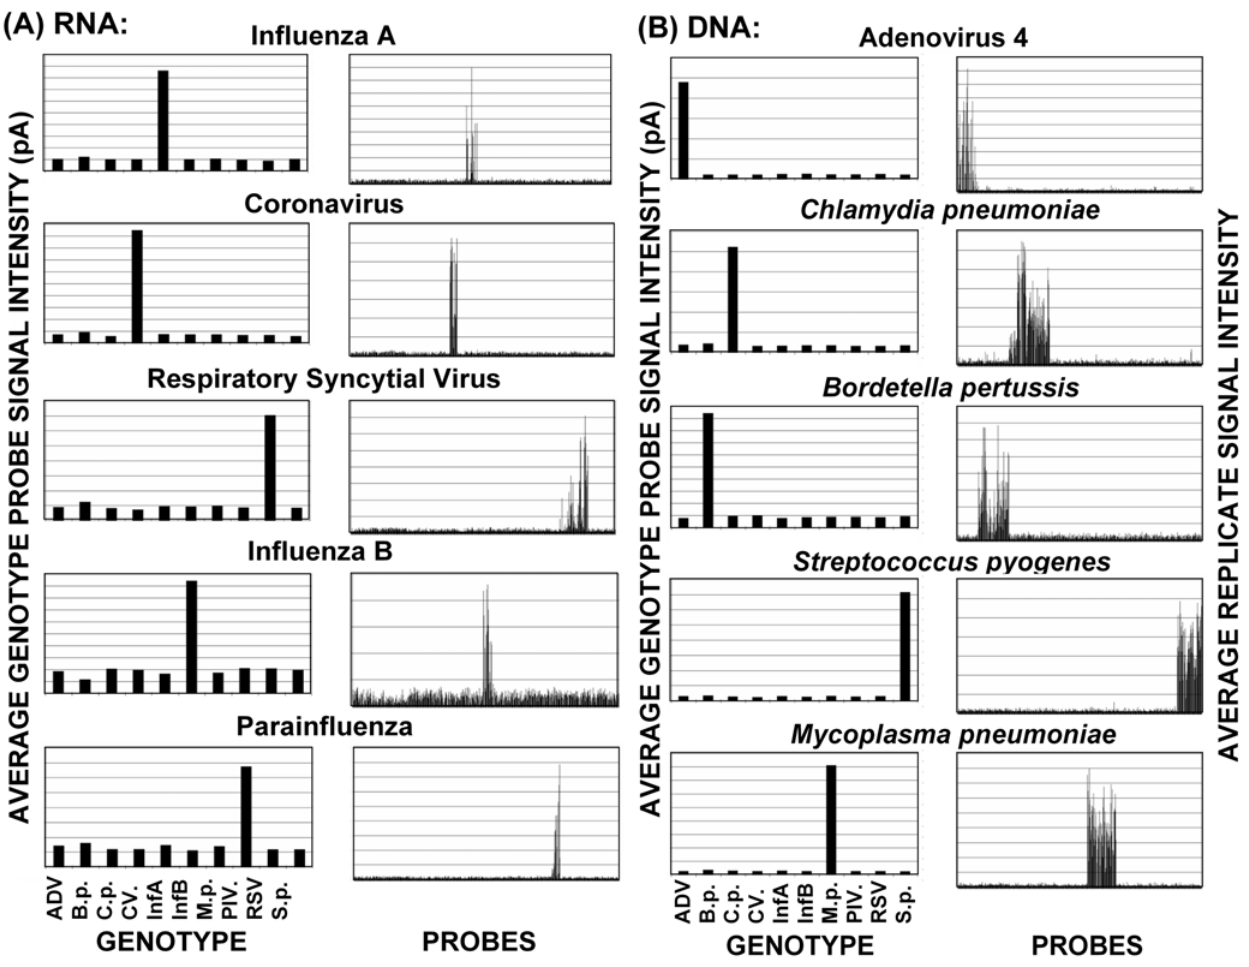
Figure 4. URI chip validation studies showing average RNA genome (A) and DNA genome (B) target signal intensity for the 10 upper respiratory pathogens studied. The left panels (GENOTYPE) show the average genotype-specific probe signal in picoamps that is used to determine a genome identity. The right panels (PROBES) illustrate the average probe signal intensities of 12 replicates for each probe and also illustrate signal specificity for both positive and negative probes. Pathogens are ADV (adenovirus 4), B.p . ( Bordetella pertussis ), C.p . ( Chlamydia pneumoniae ), CV (coronavirus), InfA (influenza A), InfB (influenza B), M.p . ( Mycoplasma pneumoniae ), PIV (parainfluenza virus), RSV (respiratory syncytial virus), and S.p . ( Streptococcus pyogenes ) at nucleic acid concentrations described in Table